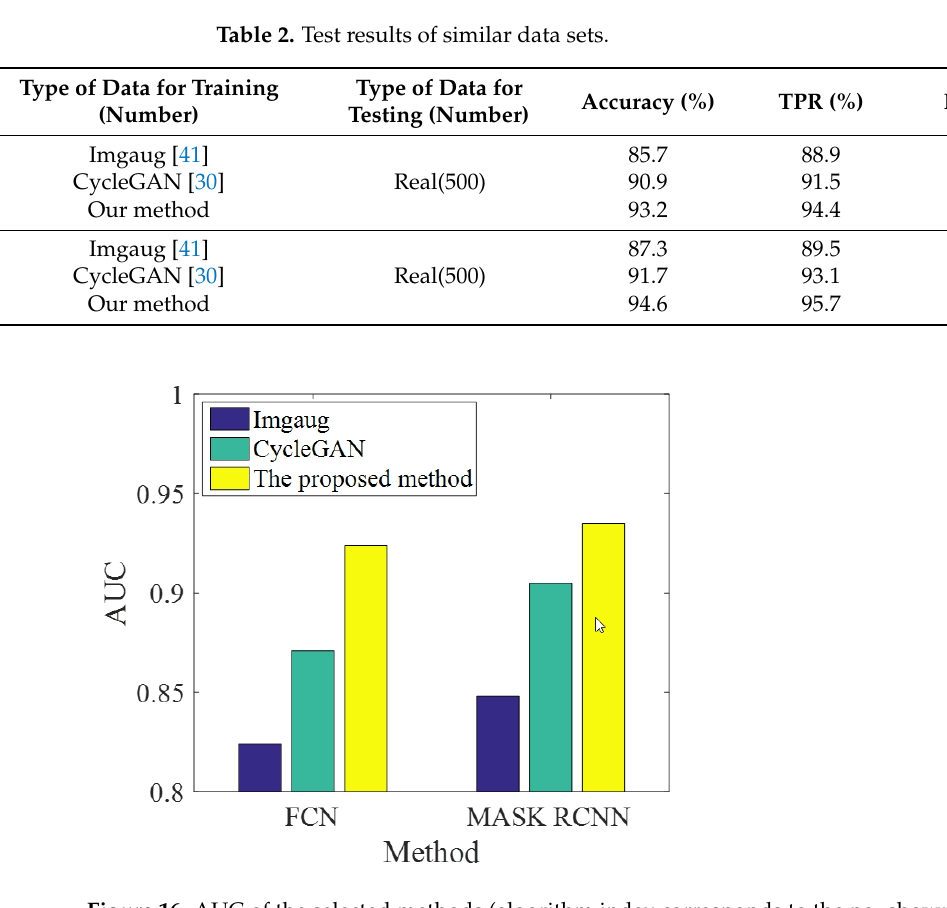
Figure 16. AUC of the selected methods (algorithm index corresponds to the no. shown in Table 2 ). The proposed method (TPR: 95.7% and FPR: 5.6%) outperformed the compared methods according to the true positive rate (TPR) and false positive rate (FPR). The FPR of the proposed method was the lowest among the compared methods. Therefore, the dataset generated by the proposed method was more effective than the other compared datasets, as confirmed by the highest AUC (0.935) (see Figure 16 ). 5. Conclusions This study proposes a novel ship image generation method and a novel ship image annotation method. The proposed method was developed based on a 3D simulated ship and CNN algorithms. Firstly, a large number of simulation ships were generated by 3D simulation software. The experimental image scene used as the background image was selected. Secondly, the proposed generation method of simulated ship images includes three key parts: (1) the posture of the simulation ship; (2) the trajectory of the ship; (3) the size of the ship. The postures of the simulation ships areselected manually according to the actual navigation posture of the ships; the trajectory and the size of the simulation ship can be computed with the model proposed in this paper. There was a high degree of similarity between the SRS image and the ship image of the real scene. The experimental results show that the SRS images achieved a higher detection accuracy than the same number of the ship images. The automatic annotation methods proposed can be used as a bounding box annotation and contour annotation. The ship image data set and automatic annotation program of this study will be published subsequently. There are still some problems to be solved in this study. First, we manually selected the posture of the 3D simulation ship according to the posture of the ship in the real scene. In a follow-upwork, the proposed method will automatically identify the ship’s posture in the real scene, on this basis, it will automatically set the 3D simulation ship posture. Second, there were about 20 kinds of ships in the 3D simulation ship dataset; thus, the number of ship types and the similarity between SRS images and real ship images need to be increased. Third, we calculated the position and the size of the simulation ship in Euclidean space. In the follow-up work, time-domain and frequency- domain characteristics will be used to calculate the position of the target ship in SRS images.